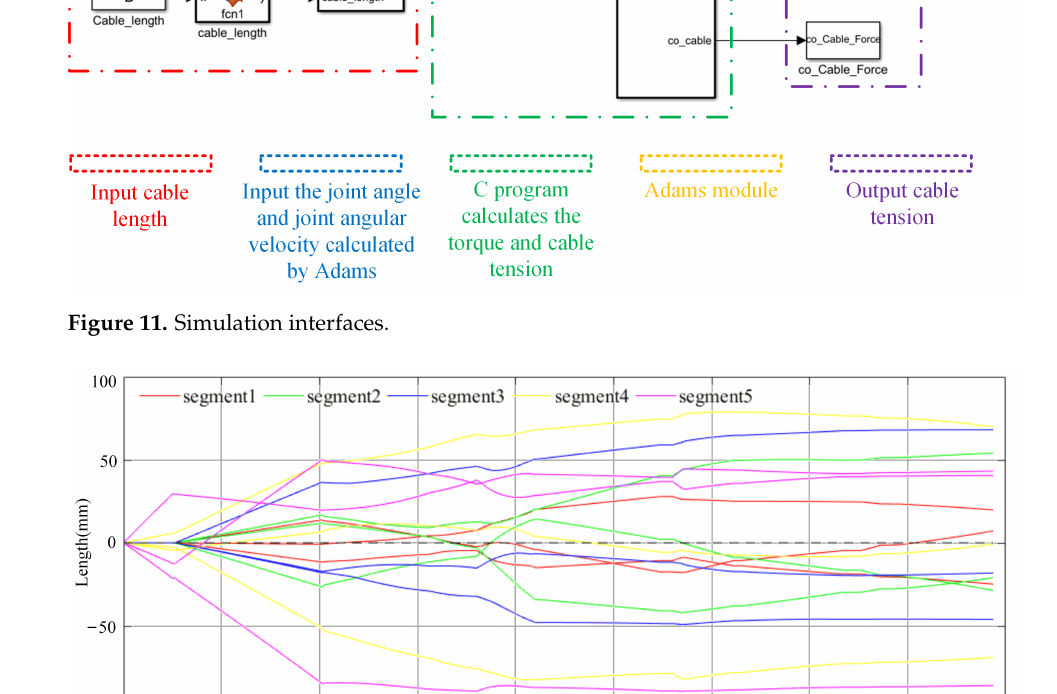
Figure 12. Cable length change